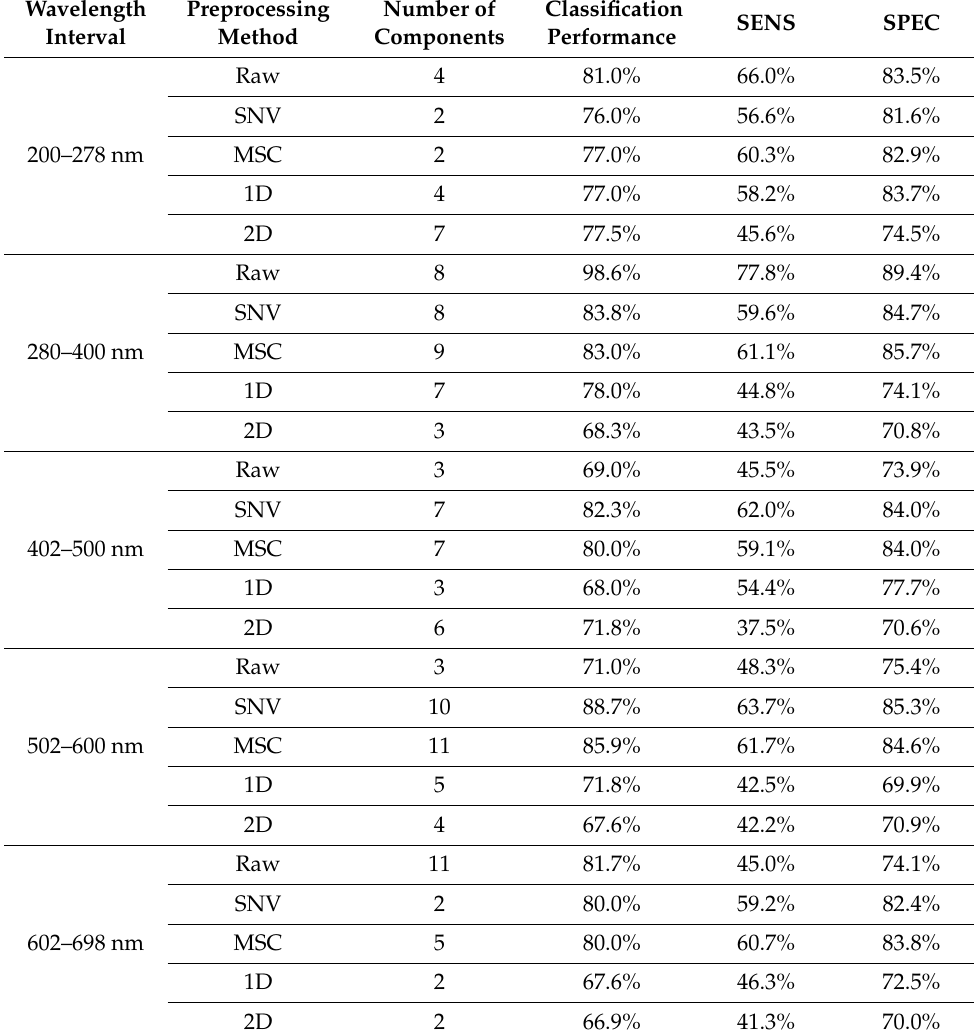
Table 2. Statistical performance of the linear discriminant analysis (LDA) models built for the differentiation of vinegars according to the PDO using the UV-Vis spectral